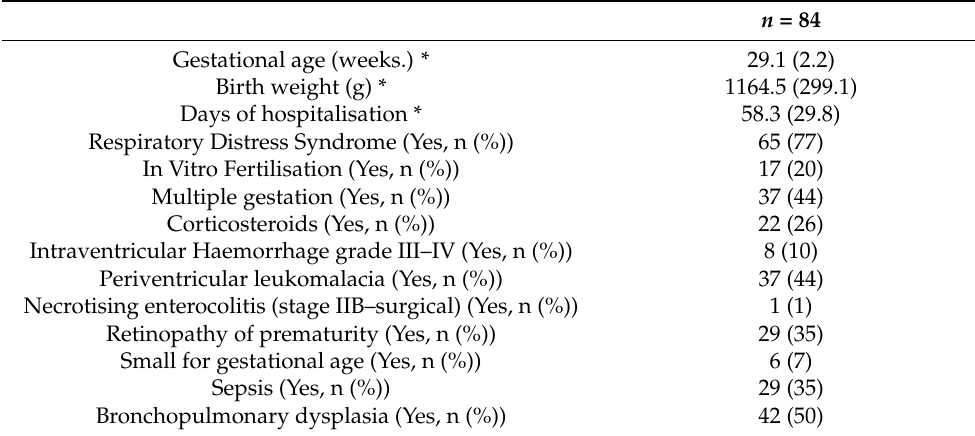
Table 1. Demographic and clinical characteristics of study very preterm